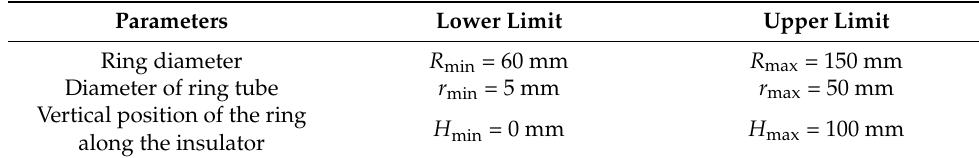
Table 6. Upper and lower limits of each parameter for the algorithm.